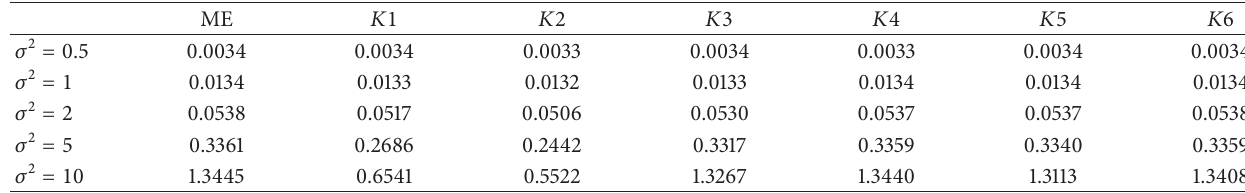
Table 10: Estimated MSE with 𝑛 = 150 , 𝑝 = 4 , and 𝛾 = 0.85